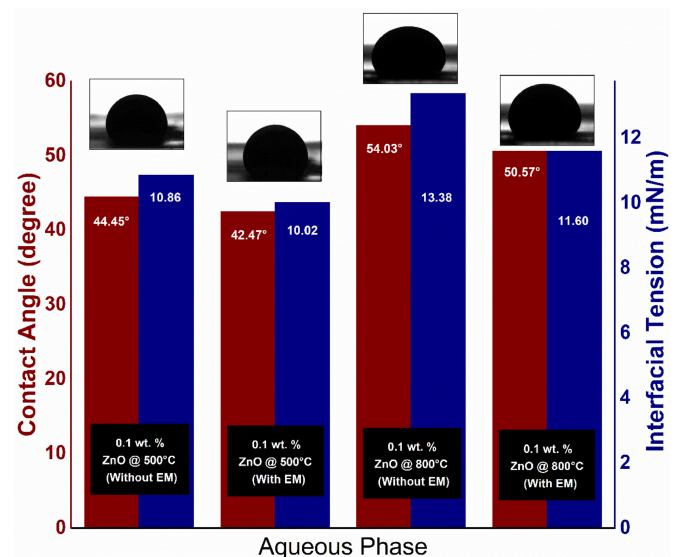
Figure 8. IFT and contact angle of the oil droplet using ZnO nanofluids under the EM field. Source: M. Adil, et al. [60] reprinted with permission.